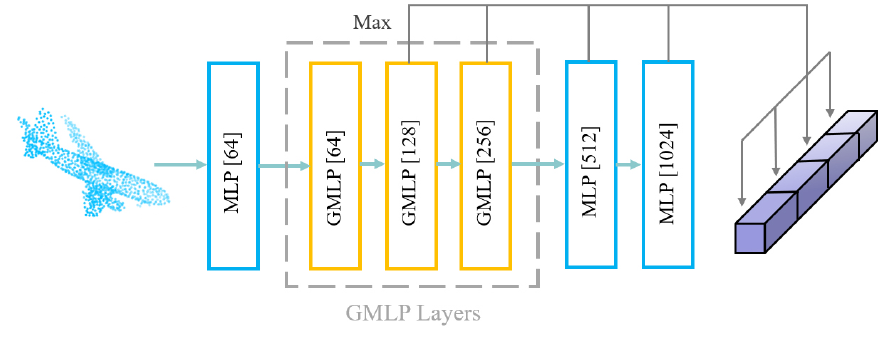
Figure 4. GCMLP in the generator of GN-GAN. We use three GMLP layers to replace MLP layers in CMLP. Combining both low-level and high-level features, the local surface information can be captured